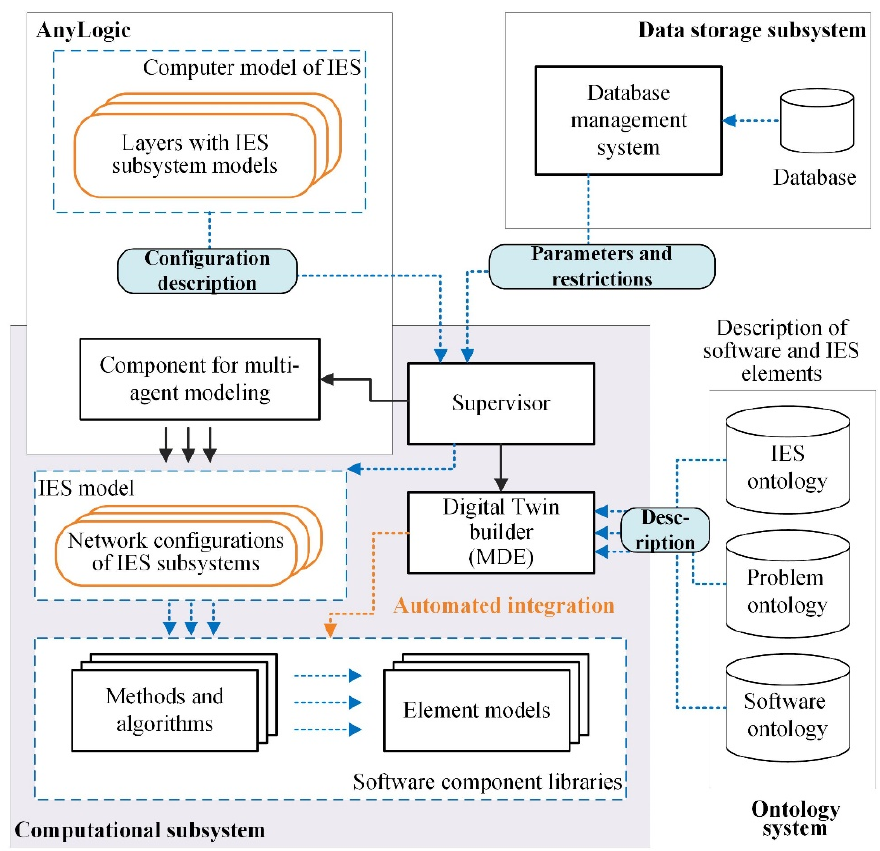
Figure 2. The architecture of the software platform for creating IES digital